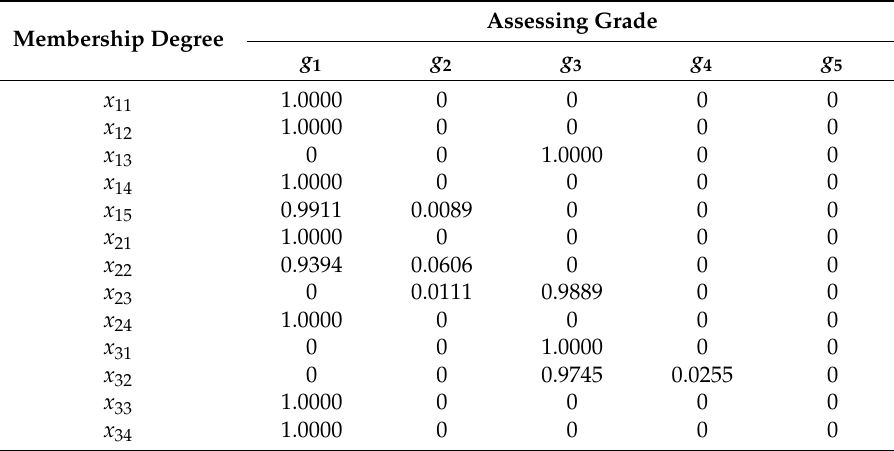
Table 5. Calculation of membership